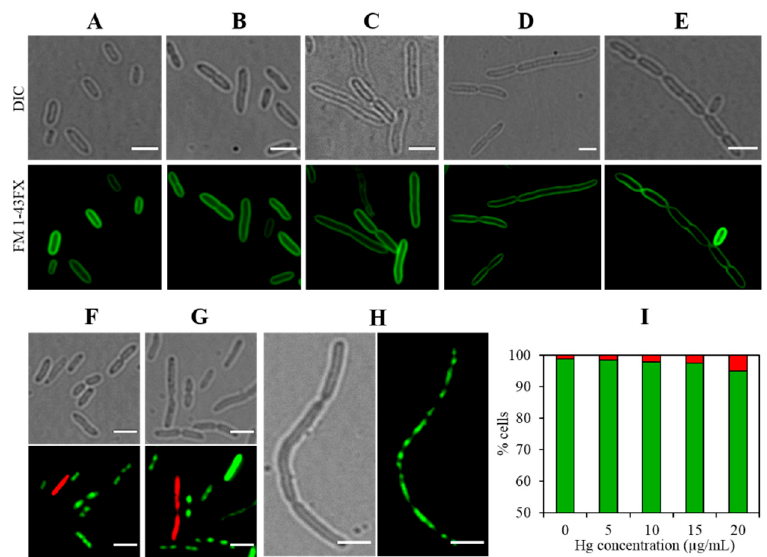
Figure 6. The cell viability assay performed on Stenotrophomonas sp. MA5 grown in the presence of Hg at concentrations ranging from 0 to 20 µ g / mL. ( A – E ) Representative fluorescence micrographs of cells stained with membrane marker FM 1-43FX. Scale bar = 5 µ m. Note that a larger area is shown in images D and E to cover the whole filamentous structure from a single cell. ( F – H ) Representative images for cell viability assay. Cells stained with green represent live and stained with red represent dead cells. Scale bar = 5 µ m. (I) The histogram shows the percentage of live cells (green in color) and dead cells (red in color), at each tested Hg concentration. More than 300 cells were observed for each treatment. Supplementary Materials: The following are available online at http: // www.mdpi.com / 2073-4409 / 8 / 4 / 309 / s1. Figure S1: Whole genome sequence-based phylogenetic tress of isolated strain Stenotrophomonas sp. strain MA5. The highest taxonomic a ffi liation of strain was found with Stenotrophomonas maltophilia based on highest number of whole genome sequence reads (979; shown in parenthesis). Displayed nodes are those with at least 4 reads ( < 1% classified reads). This tree was generated by using one codex database. Table S1: List of primers and probes used for qRT-PCR